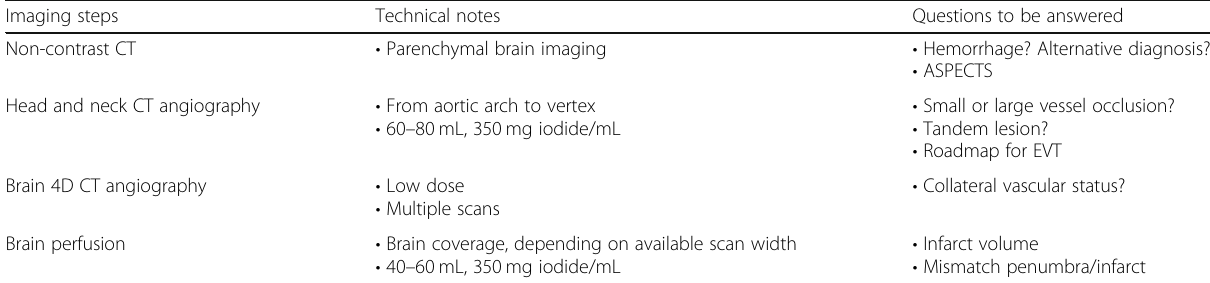
Table 1 A proposed advanced CT imaging protocol for selecting acute ischemic stroke patients for EVT Imaging steps